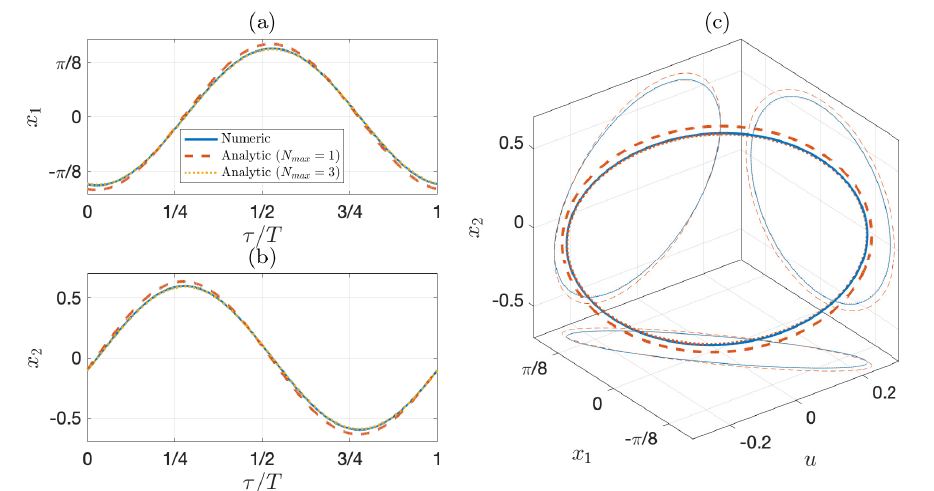
Figure 3. Comparison of the pendulum behavior predictions using the numeric and analytic solution (60) and (61) ( N max = 3) for η = 0.1428, n = 0, ω = 1.2, A = 0.1 and φ = π /3 ( T = 2 π / ω ). ( a ) x 1 vs. τ / T , ( b ) x 2 vs. τ / T , and ( c ) phase plane ( x 1 , x 2 , u )